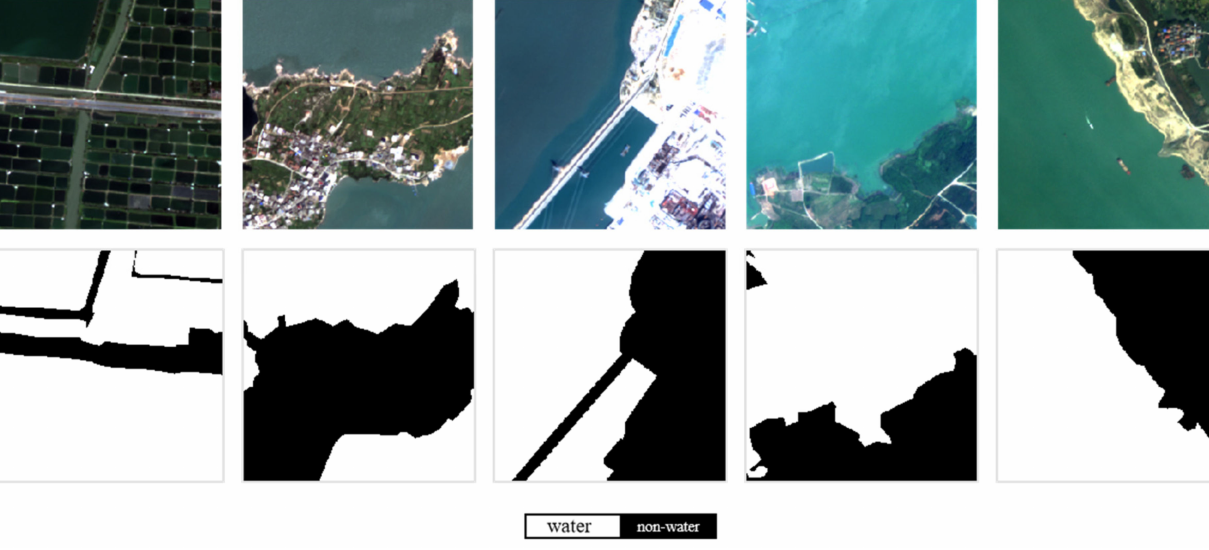
Figure 6. Raw images and ground truth masks from the GID